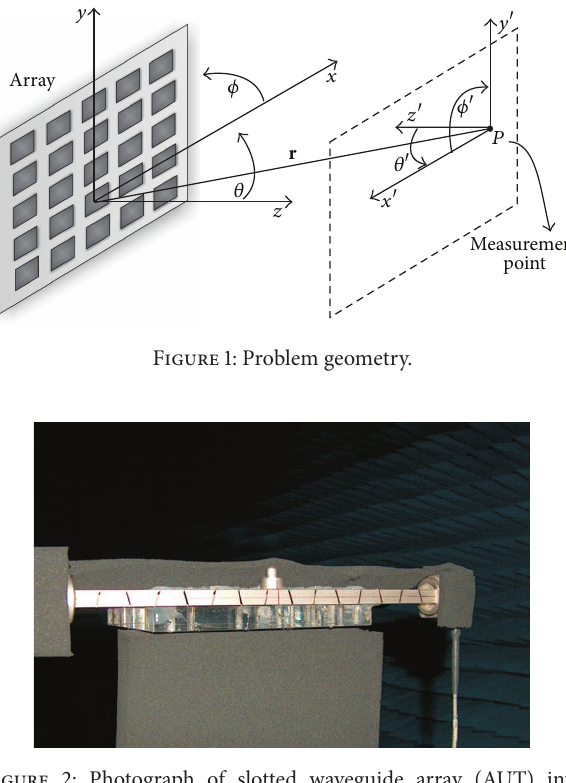
Figure 2: Photograph of slotted waveguide array (AUT) into anechoic chamber at the University of Calabria.